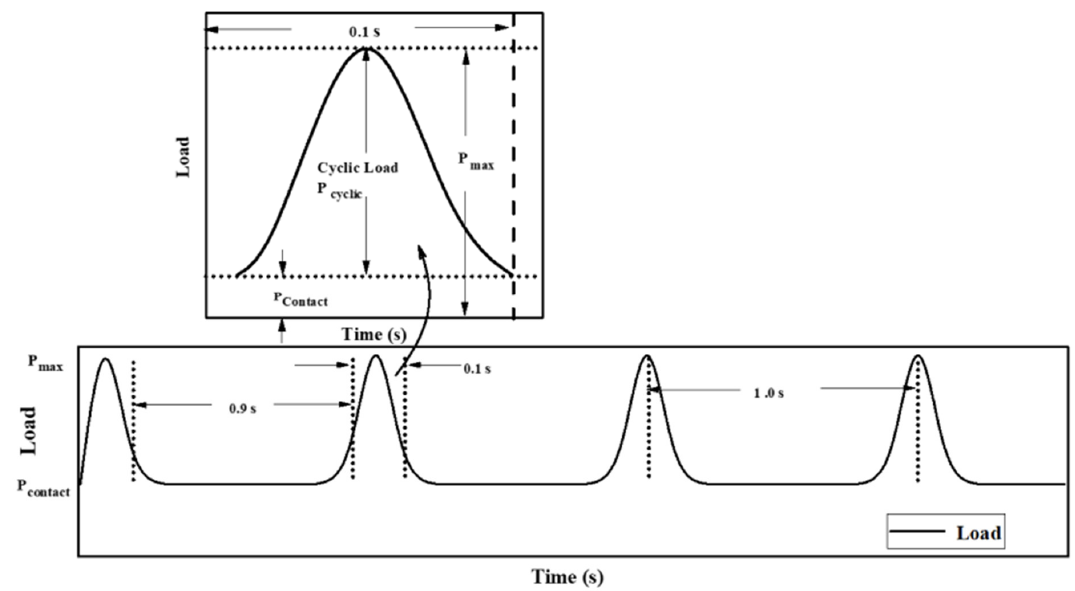
Figure 2. Typical load-time cycles with rest periods during M r test.